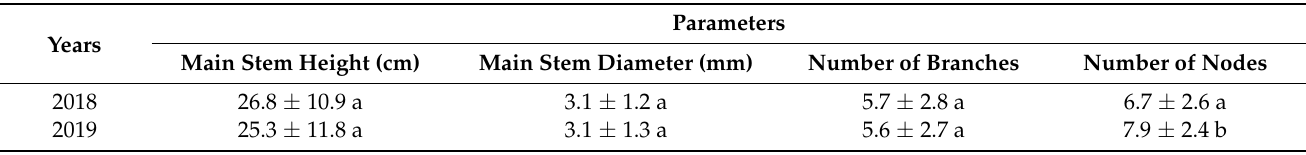
Table 1. Effect of different years on plant growth parameters of peanut.